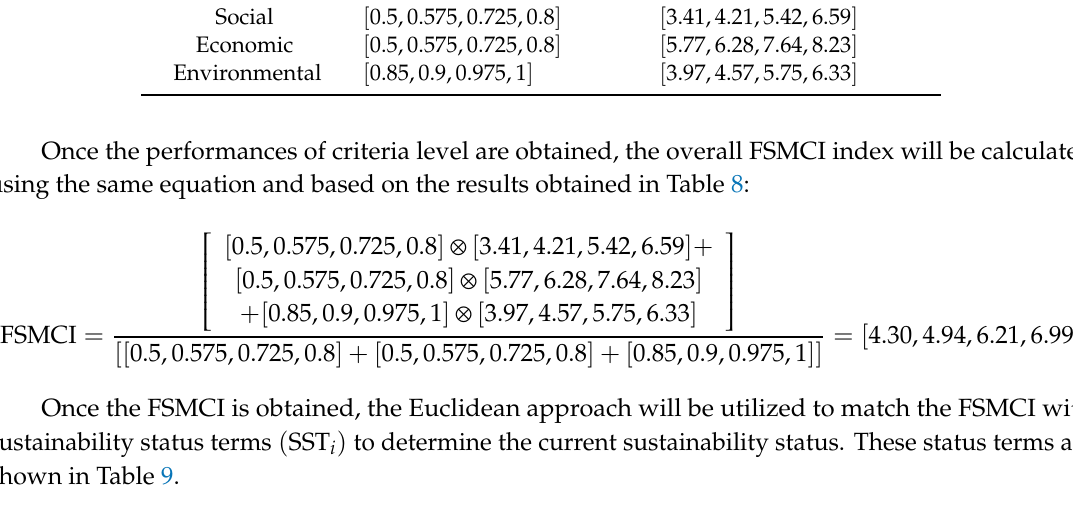
Table 9. Sustainability status terms and corresponding fuzzy sets.